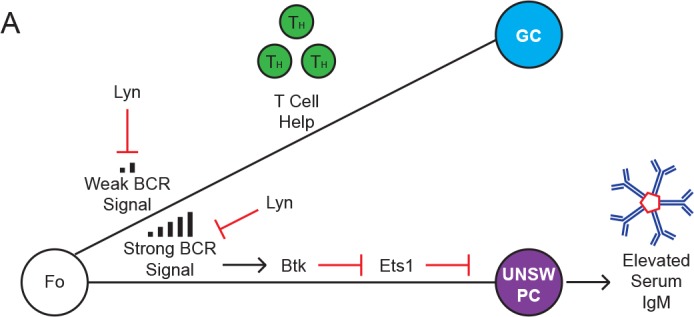
Lyn restrains unswitched plasma cell differentiation of follicular B cells.(A) Model: Lyn restrains BCR signaling in Fo B cells. Loss of Lyn leads to Btk-dependent downregulation of Ets1 expression and consequent expansion of unswitched (IgM+) plasma cells.